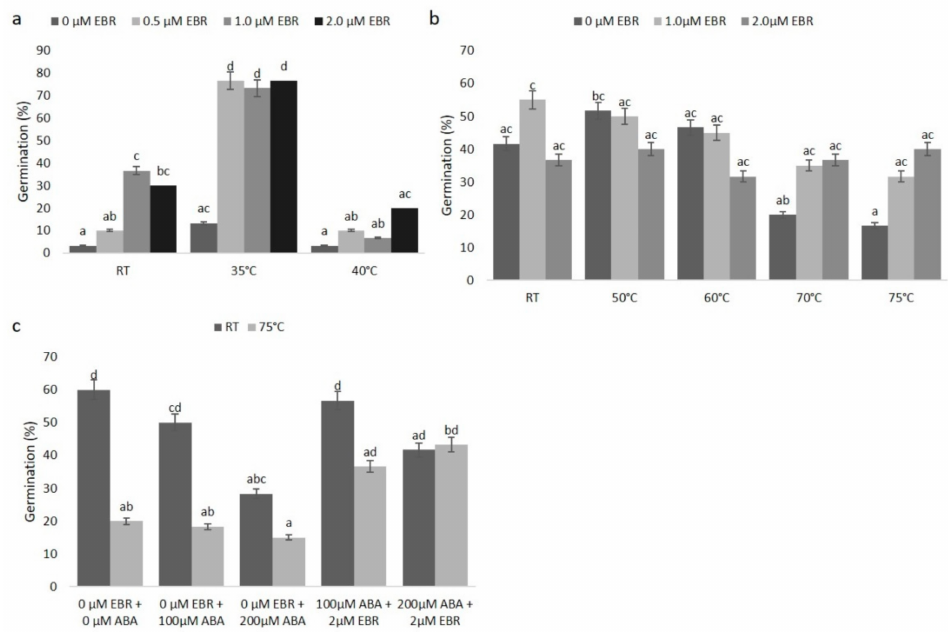
Figure 7. Cotton seed germination in response to heat stress (HS) following pre-treatment with EBR. Percent germination of Sicala V-2 seeds at day two under room temperature (RT), 35 ◦ C and 40 ◦ C following pre-treatment with 0, 0.5, 1 and 2 µ M EBR ( a ); percent germination of untreated and EBR-treated (1 and 2 µ M) Sicot 730 cotton seeds exposed for 15 min to 50, 60, 70 and 75 ◦ C and then put to germination at room temperature (RT) ( b ); and percent germination of Sicot 730 seeds pre-treated with ABA (0, 100 and 200 µ M) and ABA plus EBR (2 µ M) and then exposed for 15 min to 75 ◦ C ( c ). Error bars represent standard error (SE) of the mean for three replicates ( n = 30). Different letters above the bars indicate significant differences in two-way ANOVA ( p < 0.05) followed by Tukey’s post hoc